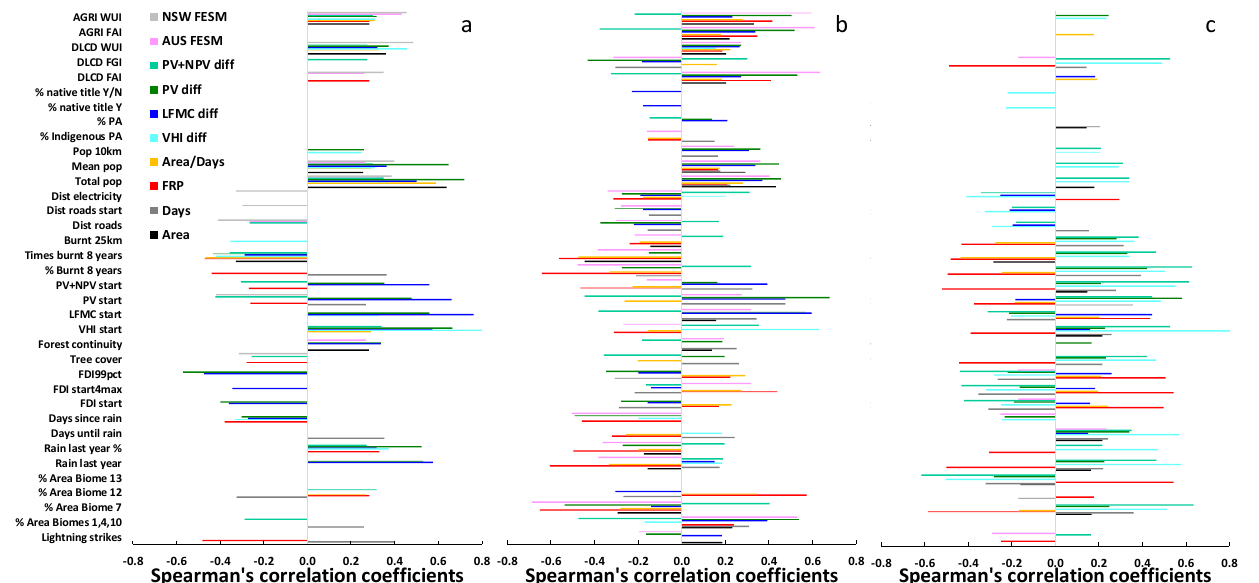
Figure 7. Spearman correlation coefficients between all explanatory variables and the 10 response variables for: ( a ) the Black Summer forest fires in SE Australia ( n = 63, except for NSW FESM severity index, where n = 45); ( b ) the Black Summer forest fires ( n = 205); ( c ) the Black Summer non-forest fires ( n = 186). The colour of the bars indicates the response variable. Only statistically significant correlations are shown.